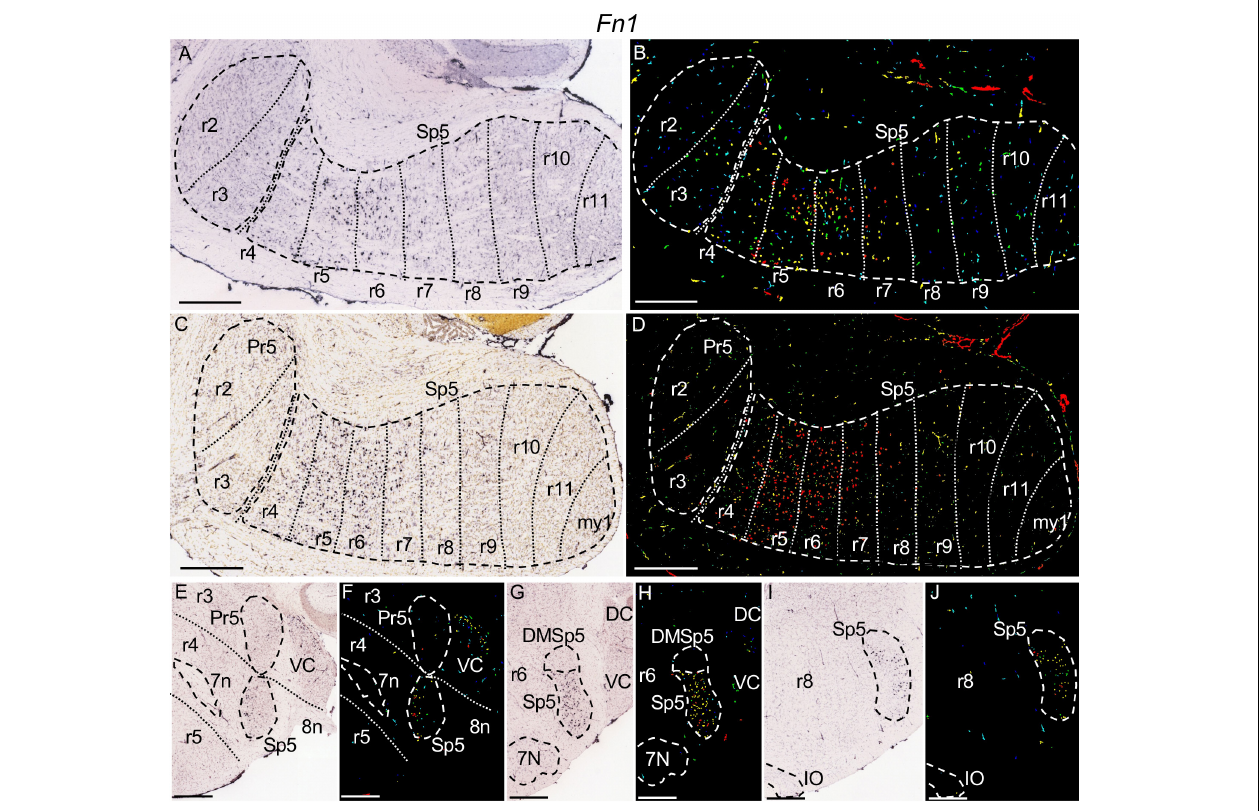
FIGURE 8 | Fn1 expression. In each image Pr5 and/or Sp5, as well as other structures indicated below, are, respectively, encircled by dashed lines. (A–D) Pairs of brightfield and color-coded images of parasagittal sections, respectively, from adult (A,B) and P28 (C,D) brains. The rhombomeric expression pattern within the trigeminal column is similar to that described for Mafb in the former figure. (E,F) Brightfield and color-coded images of a coronal section from an adult brain at the level of r4, identified by the positions of the fibers of the facial (7n) (encircled by dashed lines) and vestibulocochlear (8n) nerves. There is moderate labeling in Sp5 and in the ventral cochlear nuclei (VC). (G,H) Brightfield and color-coded images of a coronal section from an adult brain at the level of r6. 7N and Sp5, as well as the dorsomedial subdivision of the latter (DMSp5) are, respectively, encircled by dashed lines. There appears strong expression in Sp5, excluding DMSp5 which lacks expression of this gene. (I,J) Brightfield and color-coded images of a coronal section from an adult brain at the level of r8, showing weak expression in the portion of Sp5 in this rhombomere. Sp5 and the inferior olive (IO) are, respectively, encircled by dashed lines. Scale bars = 500 µ